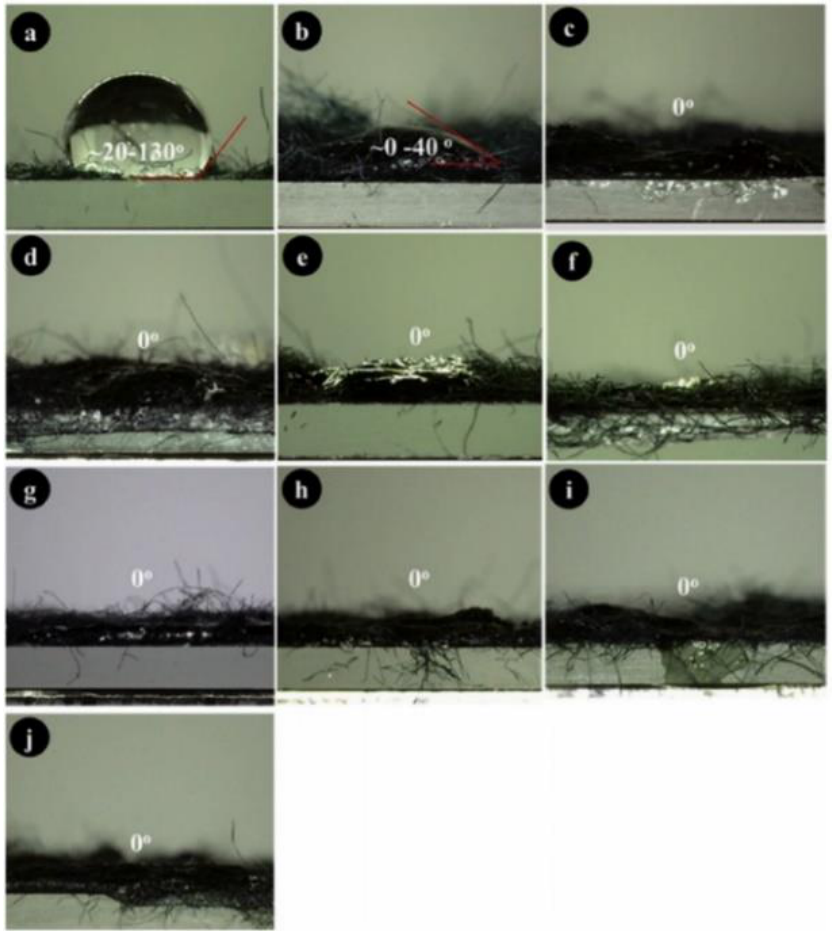
Figure 12. Water contact angle of PANI-KF nanocomposite with different ratio APS/aniline of ( a ) 0.2, ( b ) 0.4, ( c ) 0.6, ( d ) 0.8, ( e ) 1.0, ( f ) 1.2, ( g ) 1.4, ( h ) 1,6, ( i ) 1.8, ( j ) 2.0 [68] . Reprinted from Materials